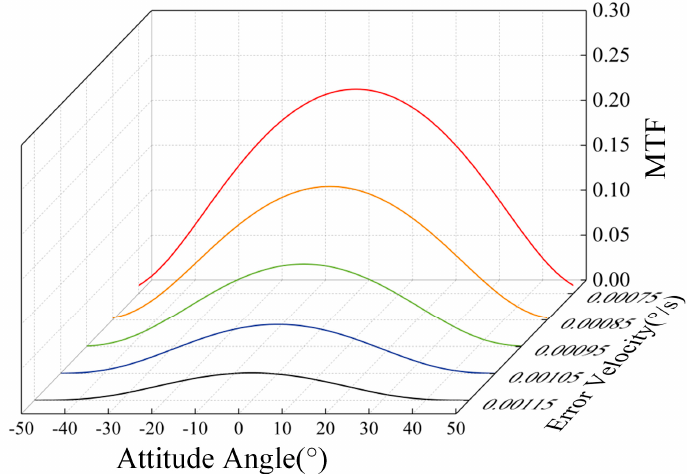
Figure 9. MTF curves of dynamic frame-by-frame imaging.